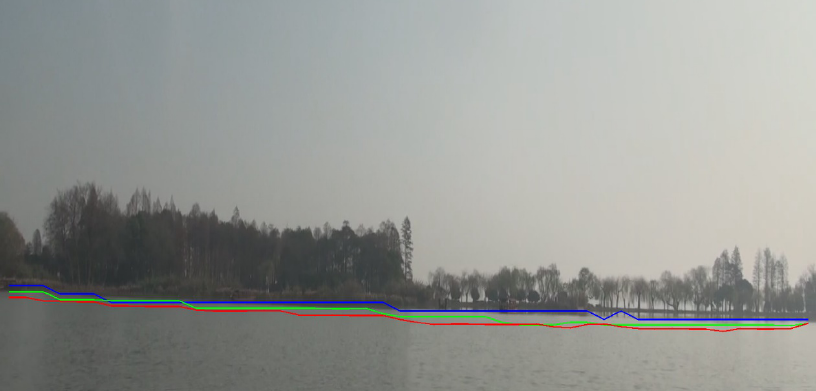
Figure 7. Visual comparisons on detection results by performing Algorithm 1 on a single image with three different strides of WLpeephole (here, blue line shows the estimated waterline in the case of h = 10 pixels, green line for the case of h = 15 pixels, and red line for the case of h = 30